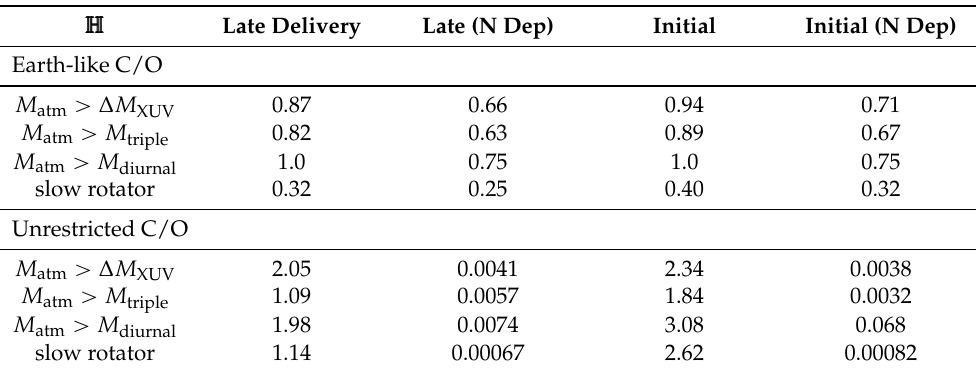
Table 1. Bayes factors for various atmospheric habitability criteria relative to the baseline case where atmosphere mass is unimportant for habitability. Small values indicate that a set of assumptions is disfavored to a corresponding degree in the multiverse framework. The cases considered are that atmosphere must be large enough to withstand XUV loss, be above the triple point of water, can buffer diurnal temperature changes, and that only slowly rotating stars are habitable. The late delivery vs. initial columns consider both potential origins of the atmosphere, and the N dep columns consider that planetary nitrogen abundance scales linearly with stellar system abundance. The top rows restrict to Earth-like values of C/O ratio, and the bottom do